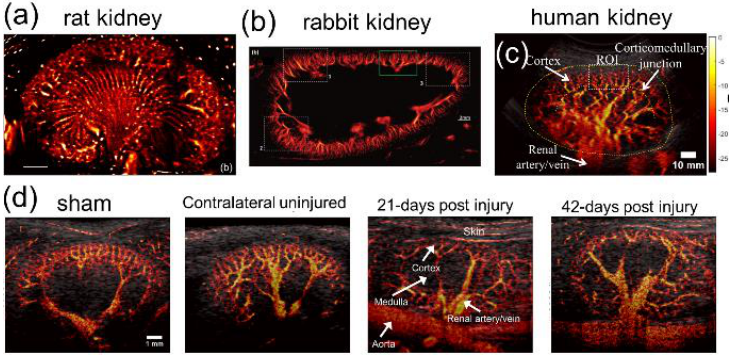
Figure 7. Representative SRU images of microvasculature from rat kidney (Reprinted with permission from [78], Copyright 2017 Springer Nature) ( a ); rabbit kidney using Kalman filter-based method (Reprinted with permission from Ref. [79]. Copyright 2020 IEEE) ( b ); healthy human kidney ( c ); mouse kidney in group of sham, contralateral uninjured, 21-days after ischemia–reperfusion injury, and 42-days post injury (Reprinted with permission from Ref. [45]. Copyright 2020 Elsevier) ( d ). On the way towards the clinical application of SRU imaging on kidneys, more affir- mative data from studies on clinically relevant animal models are required. Yang et al. performed SRU imaging on an acute ischemic–reperfused rat kidney and a normal rat kidney to investigate the in vivo feasibility of evaluating microvascular changes during progressive kidney disease. The results showed that the blood flow speed in the injured rat kidney (<10 mm/s) was much lower than that in the healthy kidney (~30 mm/s) [80]. Similar results was achieved by Andersen et al., suggesting that blood flow in the renal microvasculature was measured to be slower after ischemia and reperfusion by SRU imag- ing [81]. Studies that demonstrated the feasibility of SRU for identifying microvascular alterations during the disease progression, with a larger group of animals and histological verifications, were performed by Chen et al. [45]. In the study, SRU imaging was performed in vivo on mouse kidneys of four different groups (n = 5), including control, kidneys post 21 days of ischemia–reperfusion injury, and kidneys post 42 days of injury (Figure 7d), followed by the histological analysis with a CD31 stain. The results showed that SRU imaging was able to identify renal microvessels as small as 32 µ m (<1/3 λ at the frequency of 15 MHz) in vivo and allow for quantification of the changes in kidney morphology and vasculature, including size, rBV, vessel density, and tortuosity, during the progression of the kidney injury. Changes in renal vascular density in the corticomedullary area